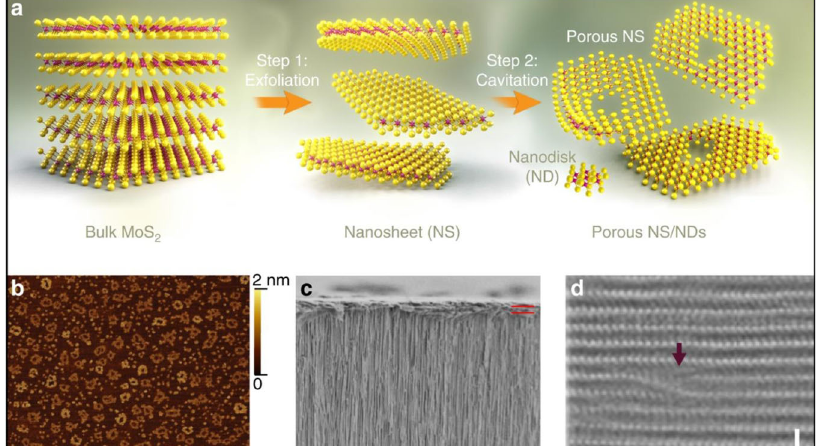
Fig. 6 Porous MoS 2 nanosheet. a Shows the two-step process representation of the high permeability sub-nanometre nanoporous composite MoS 2 membranes. b The as-prepared topographic atomic force micrographs of the porous NSs. c The cross-section SEM image of the laminate composite of NS/ND membrane ( d ) Shows the high-resolution HAADF STEM image of a laminate cross-section of 6.2 Å interlayer spacing and showing defects in the interlayer voids/defects as shown with the arrow. Reproduced with permission from Sapkota, B. et al. Nat. Commun. 11, 2747, 2020; licensed under a Creative Commons Attribution (CC BY) license 40